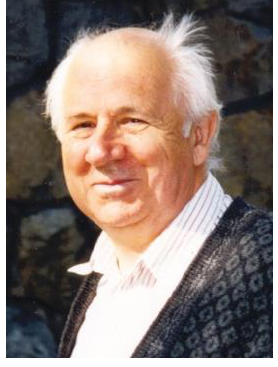
Figure 1. Dr. Sre´cko